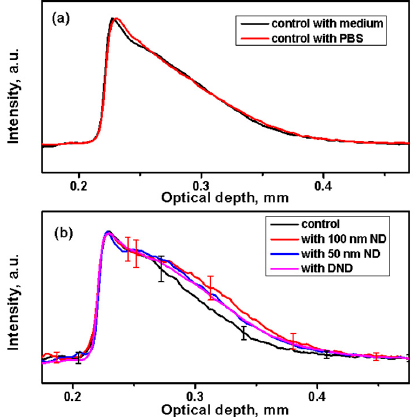
Figure 4. Analysis of A-scan profiles of the backscattering signal of NDs in the skin. ( a ) Averaged A-scan profiles from control samples of black skin after a 24 h incubation in a medium or phosphate-bu ff ered saline (PBS). ( b ) Comparison of averaged A-scans of the control (in PBS) and skin treated with suspensions of NDs for 24 h.